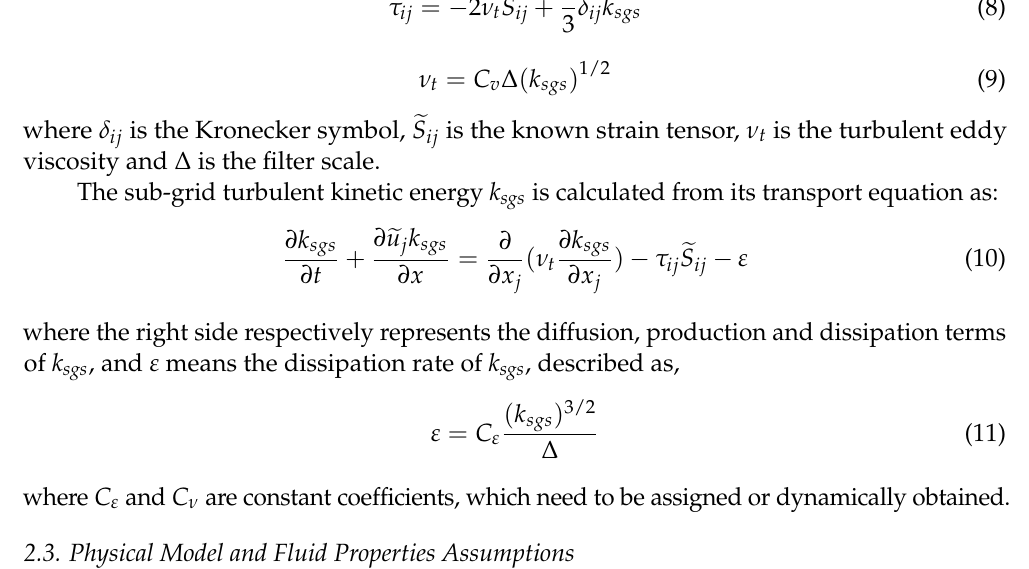
Figure 2. Surface tension and kinematic viscosity curves of MMH. Due to the large-scale change in the spray domain, the extremely high requirement for the computing power makes it challenging to use structured grids with a very tiny size for capturing the liquid–gas interface in detail. Kevin [28] pointed out that an appropriate adaptive grid method can improve the computational efficiency in the spray atomization process. Therefore, the adaptive mesh refinement in OpenFOAM [29,30] was employed with a liquid–gas interface gradient, as shown in Figure 3. The initial grid side length is 0.1 mm after three refinements at the maximum, so the mesh size can be reduced to 0.0125 mm to adequately capture the droplets’ size of 50–100 μ m, measured by the PDPA (phase doppler particle analyzer). For mesh independence validation, two initial mesh sizes of